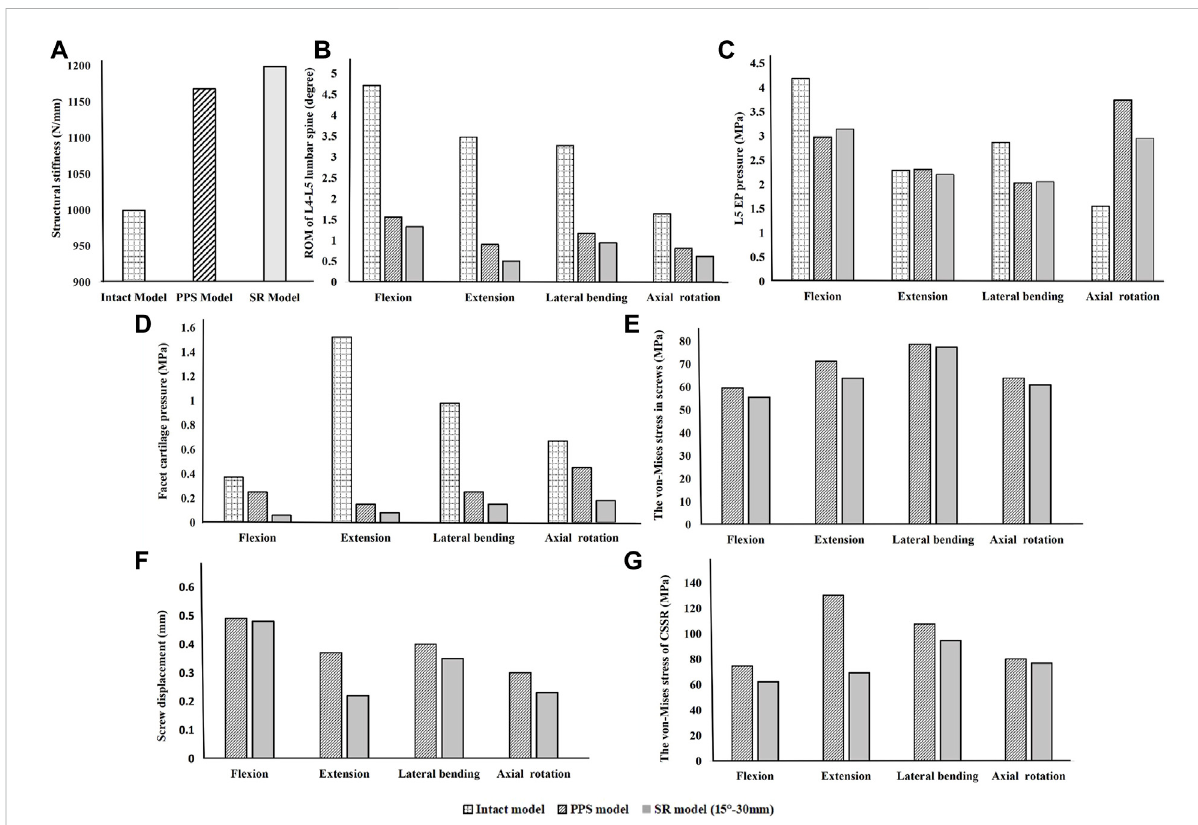
FIGURE 9 Comparison of the intact model, PPS model, and SR model. (A) Axial stiffness, (B) ROM, (C) endplate pressure, (D) von-Mises stress on facet cartilage, (E) von-Mises stress in screws, (F) displacement of pedicle screws, and (G) von-Mises stress at CSSR under fl exion, extension, lateral bending, and axial